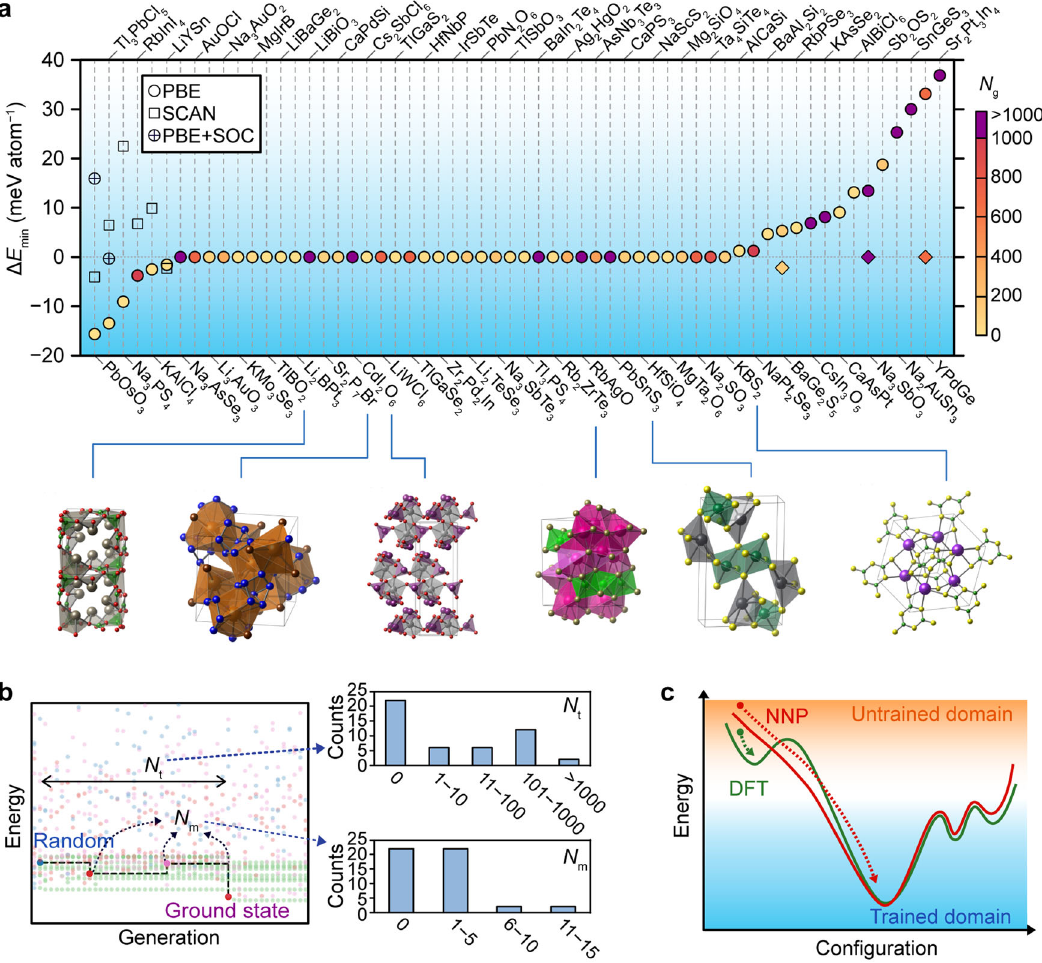
Fig. 2 Search results of SPINNER against structures in the ICSD. a Distribution of the energy difference between the most stable structure found by SPINNER and the ICSD structure ( Δ E min ). The negative, zero, and positive Δ E min indicate that SPINNER found more stable structures than the ground state, exact ground states, and metastable structures, respectively. The color codes indicate the generation at which the lowest-energy structure was identi fi ed ( N g ). The circle, square, and sun cross indicate the exchange-correlation functional and diamonds are results obtained with the conventional cell. Equilibrium structures of some compositions with Δ E min = 0 are displayed below. b De fi nition and distribution of N t and N m for materials with Δ E min ≤ 0; N t denotes the number of generations that elapsed from random seeding until the ground state is identi fi ed, and N m is the number of mutations involved in this process. N t = 0 means that the ground state is directly obtained by relaxation from a random structure. c , Schematic illustration of potential energy surfaces by the DFT and